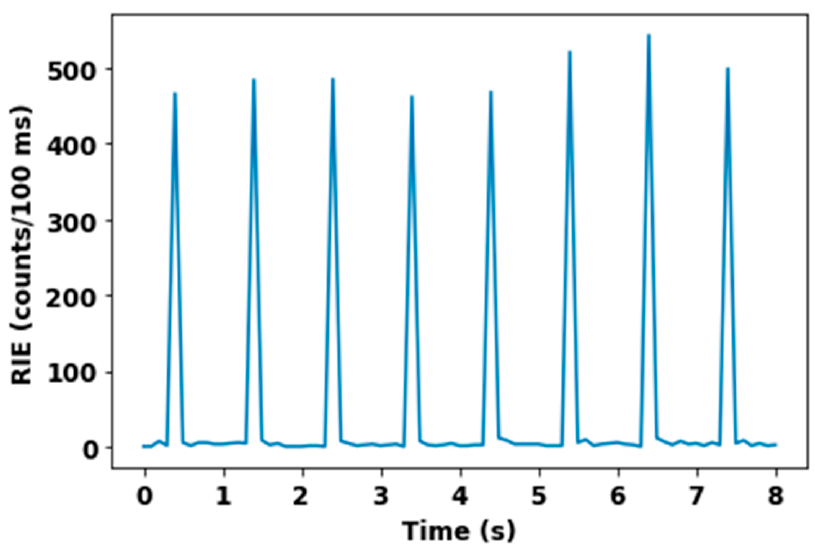
Figure 6. RIE peaks related to the interaction of the N-doped fiber with 8 ELSA X-ray pulses. From each irradiation pulse set, the measured RIE is summarized in Figure 7 with the corresponding pulse number in the x-axis. This is composed of two main irradiation periods colored successively in blue and orange. The first period was carried out with a mean dose rate of 1.3 MGy(SiO 2 )/s. Because of the fluctuations of the accelerator, the stability of the X-ray beam production had to be tuned sometimes. To keep the stability, some beam parameters were adjusted, such as the X-ray flash duration or the electron charge responsible of the dose rate of the X-ray pulse. Because of this change, which directly affected the dose rate delivered by the accelerator, the RIE followed the same evolution, as illustrated by the step around the 1300th pulse. After the adjustment of the beam parameters to stabilize the accelerator, the used dose rate was around 1.7 MGy(SiO 2 )/s. This experiment illustrates how the fiber monitor could complement the existing technologies, allowing us to acquire key information about all the delivered pulses by the ELSA facility. In particular, the small-size optical fiber allowed us to follow the pulse-per-pulse dispersion in terms of dose rate in real-time, leading to a more precise estimation of the deposited dose on the device under